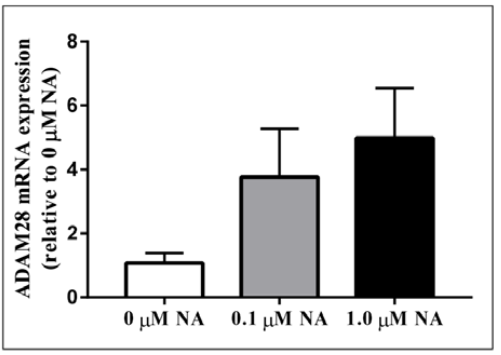
Figure 4. Noradrenaline treatment of human THP-1 monocytes promotes elevated ADAM28 mRNA expression. Cells were treated for 48 h.